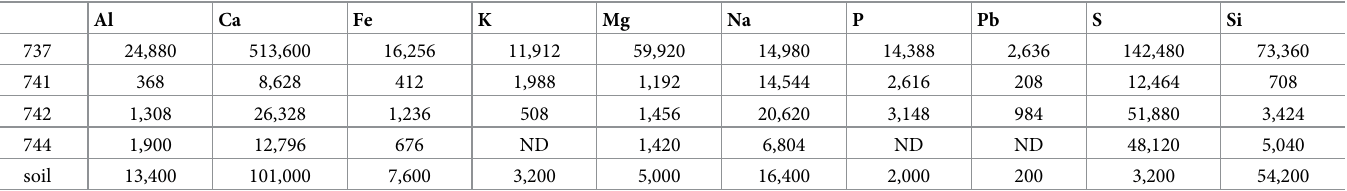
Table 4. The ICP-AES elemental composition of each artefact (ppm).